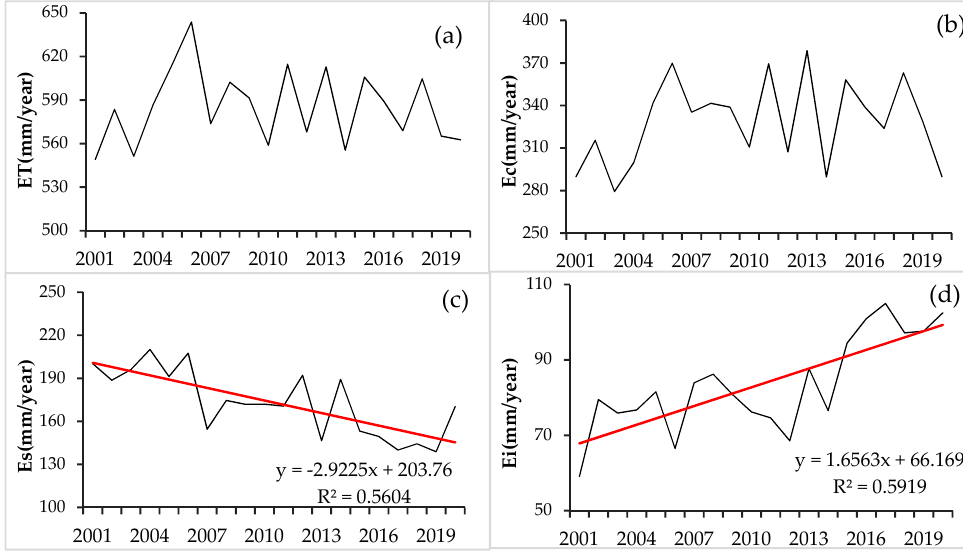
Figure 4. The temporal variation of annual ET( a ), Ec( b ), Es( c ), and Ei( d ) from 2001 to 2020. The spatial distribution of annual ET and its components during different impound- ment periods are shown in Figure 5. ET and Ec changed significantly from stage 1 to stage 2, they increased by 7.7% and 12.2% in the whole TGRA, 15.0% and 17.8% in the head of TGRA, and 6.9% and 12.5% in the tail of TGRA, respectively. While in the central part of TGRA, ET and Ec increased slightly, from 548.4 to 579.7 mm and 287.8 to 313.5 mm, respectively. They changed little from stage 2 to stage 5. Es in the urban area increased significantly by 27.8% from stage 1 to stage 2; however, it sharply decreased from 385.9 to 349.9 mm from stage 2 to stage 3, with forest land and cultivated land decreasing by 10.8% and 21.9%, respectively. From stage 3 to stage 5, Es decreased slightly by 6.2% which also